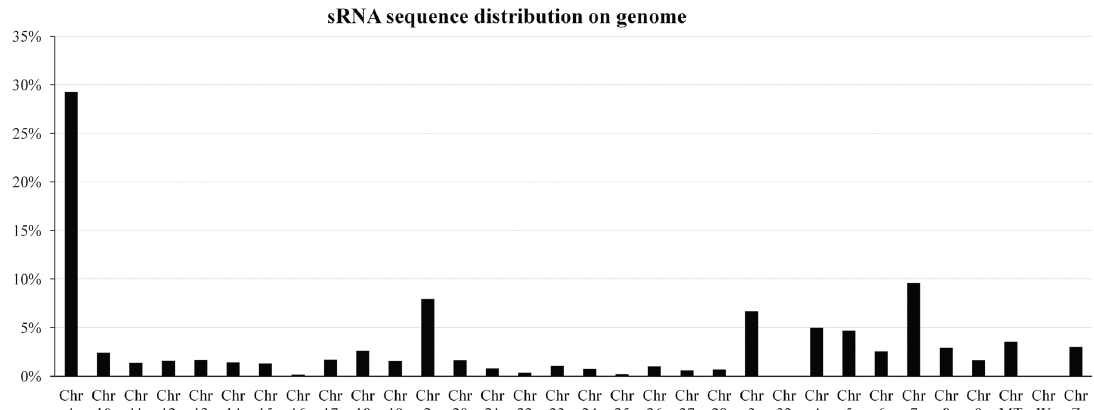
Figure 2. Distribution percentages of unique small RNAs sequences on chicken chromosome. The unique small RNA reads were mapped to chromosome by BLASTing with the chicken genome; and then the percentages of mapped reads of each chromosome in total mapped reads were then calculated. Chr MT: mitochondrial genome.